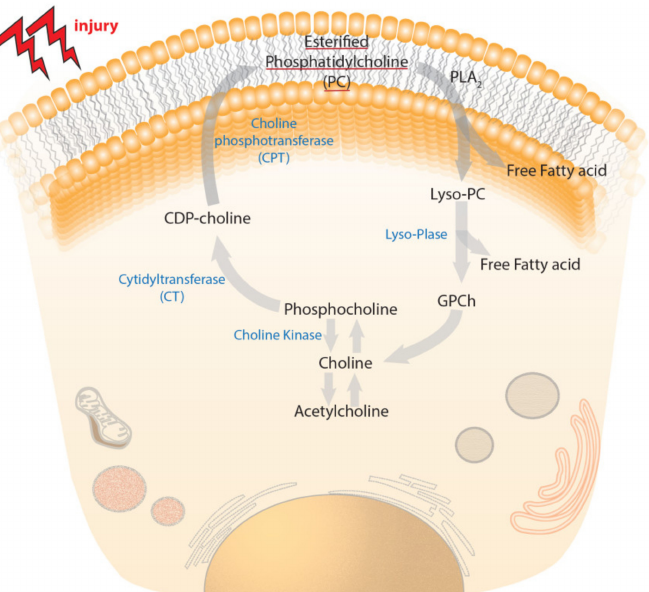
Figure 4. The depiction of biosynthesis and degradation of phosphatidylcholine. In the anabolic pathway, phosphorylation of choline takes place by choline kinase (CK), yielding phosphocholine, which is followed by condensation of phosphocholine catalyzed by cytidylyltransferase (CT), re- sulting in the formation of CDP-choline. Later, the coupling of phosphatidic acid and CDP-choline by choline-phosphotransferase (CPT) results in phosphatidylcholine synthesis. The breakdown of phosphatidylcholine results in the formation of lyso-phosphatidylcholine and free fatty acids (FFA) in the presence of PLA 2 . Lyso-PC quickly hydrolyzed to form FFA and glycerophosphocholine that form free choline, or phosphocholine through hydrolysis, by the action of alkaline phosphatase. Other choline-containing PLs include sphingomyelin (SM) which is abundant in the myelin sheath and maintains the integrity of the axonal covering [35]. SM is also reported to take part in cellular processes, signal transduction and the inflammatory cascade [36].